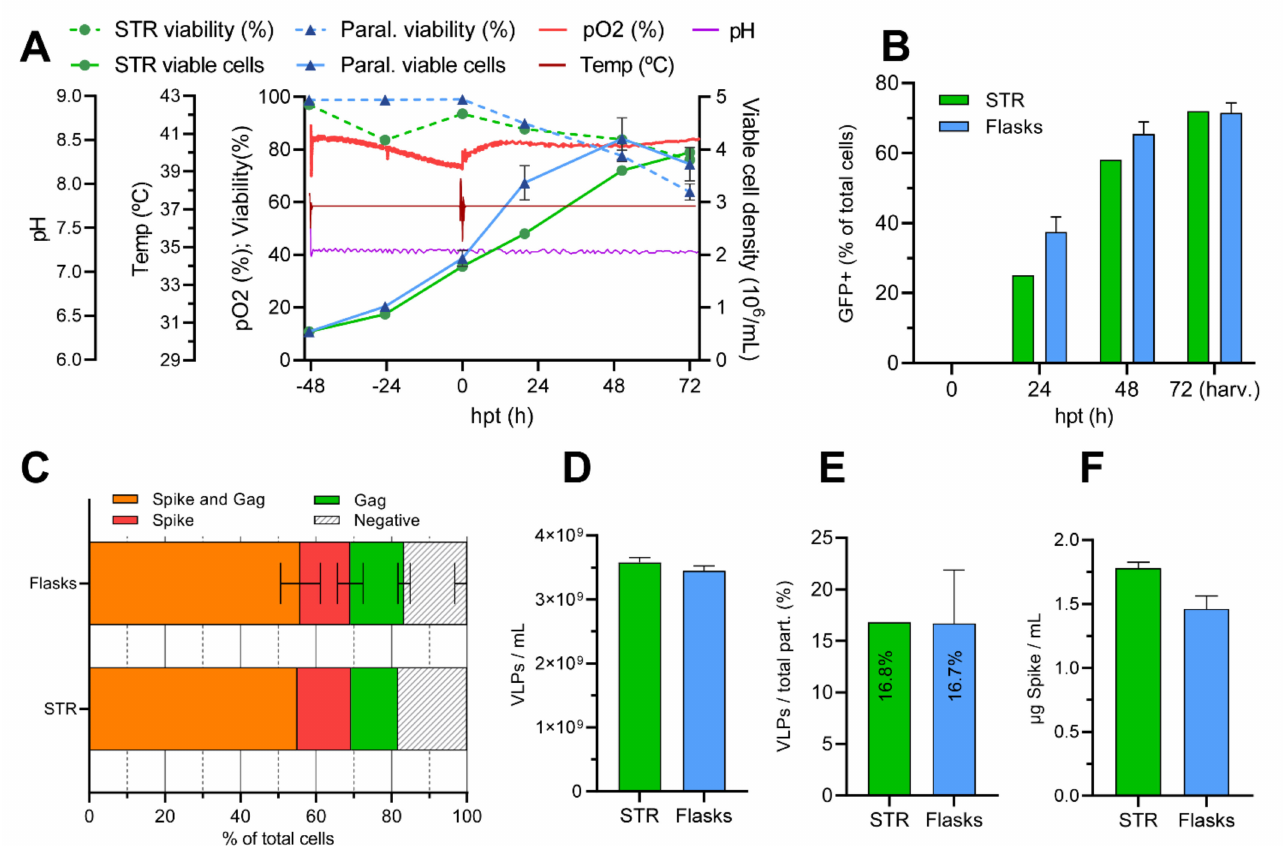
Figure 4. Production of S-VLPs in a stirred 1 L bioreactor and harvest analysis. ( A ): Online profile measurements of different process parameters: Temperature, pH and dissolved oxygen concentration (pO2). Cell density and cell viability values are also shown. The arrow indicates the moment of transfection. ( B ): Transfection kinetics: percentage of Gag::eGFP-expressing cells (single- or double-positive) at different time points after transfection. ( C ): Immunocytochemistry analysis at 72 hpt. STR and shake flasks show a similar percentage of double-transfected populations (55.1% and 55.8%, respectively), together with a ~27% population of single Gag::eGFP-positive cells and a ~13.7% percentage of single S-expressing cells. ( D ): Harvest VLP concentrations, measured by NTA fluorescent particle analysis. ( E ): Harvest purity, which illustrates the percentage of VLPs from the total particles present at the harvest, by NTA fluorescent and non-fluorescent particle analysis. ( F ): Harvest SARS-CoV-2 spike concentrations, analyzed by dot